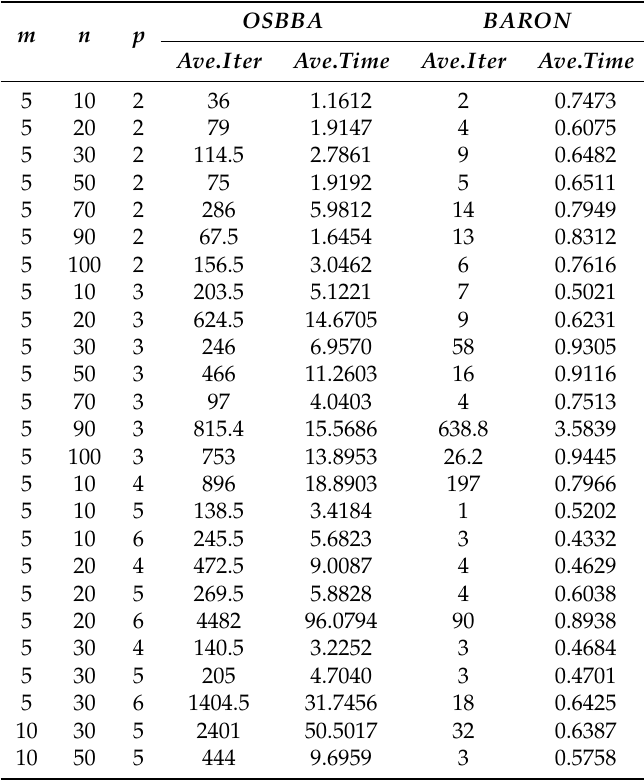
Table 6. The results of random calculations for Example